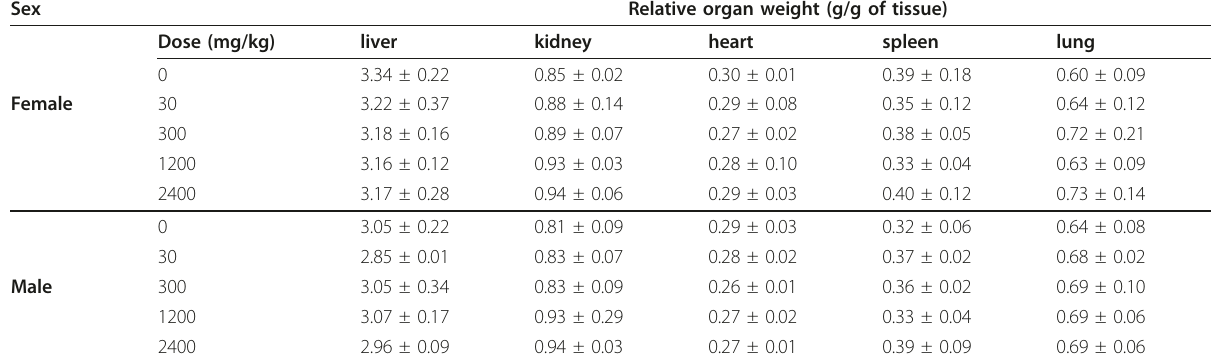
Table 2 Effect of dose and sex on organ relative weights of rats in sub-acute toxicity studies of the ethyl acetate extract from C.